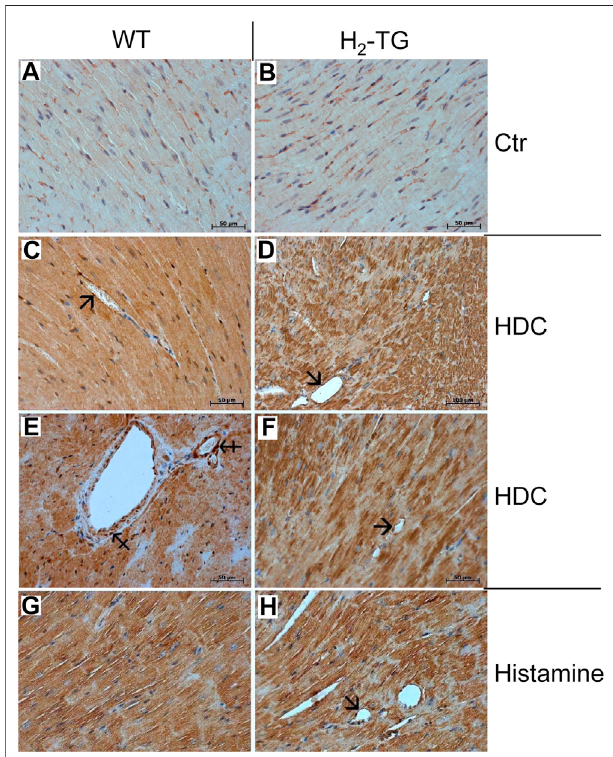
FIGURE 10 | Immunohistochemical localization of histidine decarboxylase (HDC) and histamine in the mouse myocardium. (A,B) Negative controls (Ctr) of WT and H 2 -TG samples. HDC could be localized in themyocardiumofWTmice (C,E) andinthemyocardiumofH 2 -TGmice (D,F) .Positiveimmunostainingwasobservedinthecardiomyocytesaswellas in the endothelium (arrows) and in the vascular smooth muscle cells (tailed arrows) of blood vessels (G,H) Immunohistochemical localization of histamine inthemyocardiumofWT (G) andH 2 -TG (H) mice.Alongwithcardiomyocytes, positive immunostaining can also be seen in the endothelium (arrow). Immunocomplexes were detected by DAB-HRP staining (brown staining) followed by counterstaining of nuclei with haematoxylin. Horizontal bars indicate 50